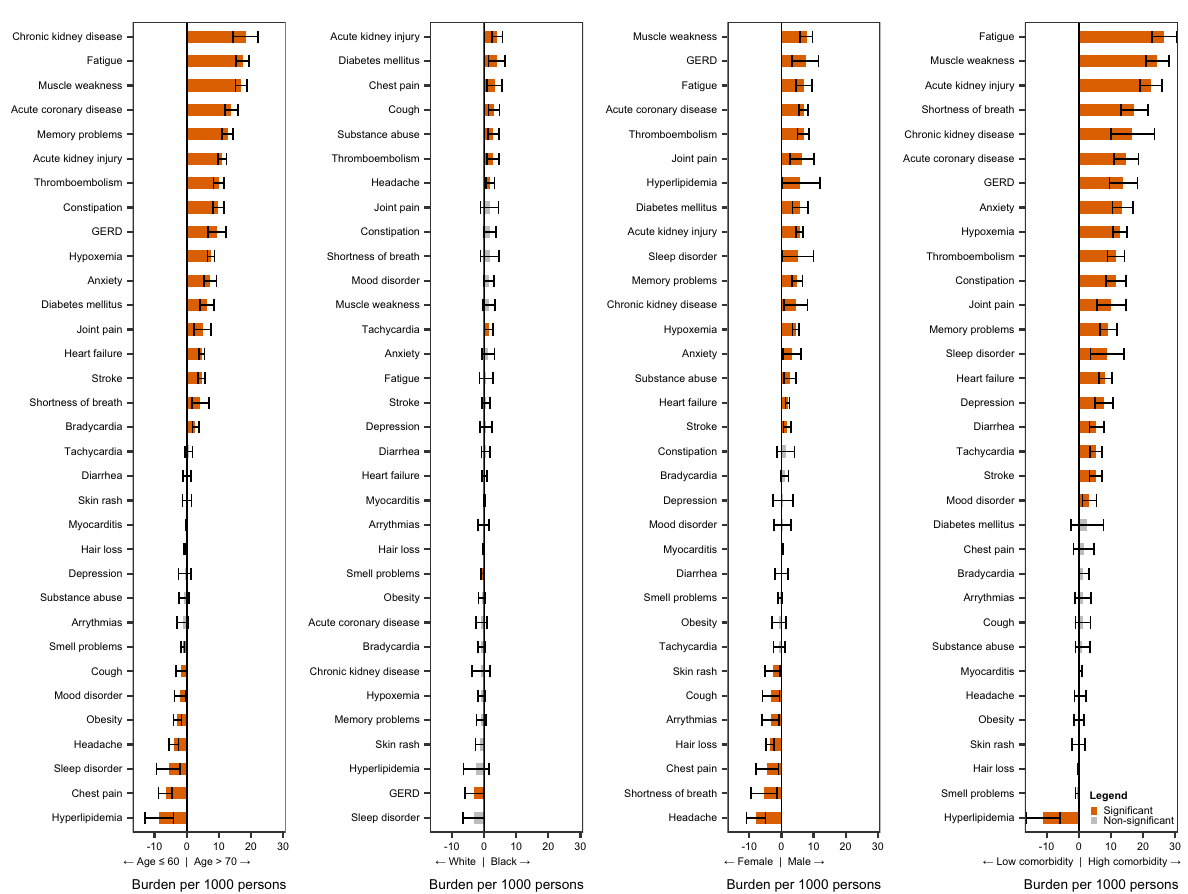
Fig. 4 Differences in burden of individual post-acute sequelae of COVID-19 by age, race, sex, and health status. Differences in burden per 1000 COVID- 19 patients at 6 months are presented along with 95% con fi dence